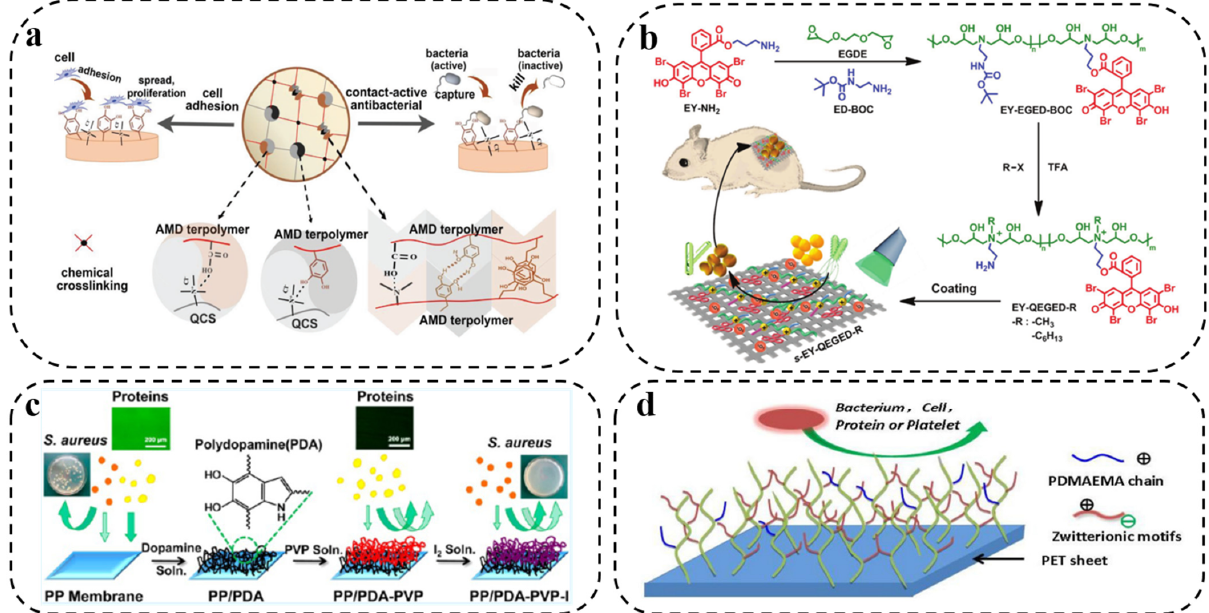
Figure 5. ( a ) Design strategy of cell-affinitive and contact-antibacterial AMD-QCS hydrogel. Reprinted with permission from [84] (copyright: Wiley-VCH, 2018). ( b ) Schematic illustration of the antibacterial coating formed by eosin Y (EY)-based antibacterial polycation via polydopamine. Reprinted with permission from [86] (copyright: Wiley-VCH, 2018). ( c ) Scheme of coating polydopamine (PDA) on a PP membrane as well as subsequent PVP and iodine complexation. Reprinted with permission from [68] (copyright: American Chemical Society, 2013). ( d ) Schematic diagram of surface-activated ATRP on PET sheet surface. Reprinted with permission from [87] (copyright: Elsevier, 2016).